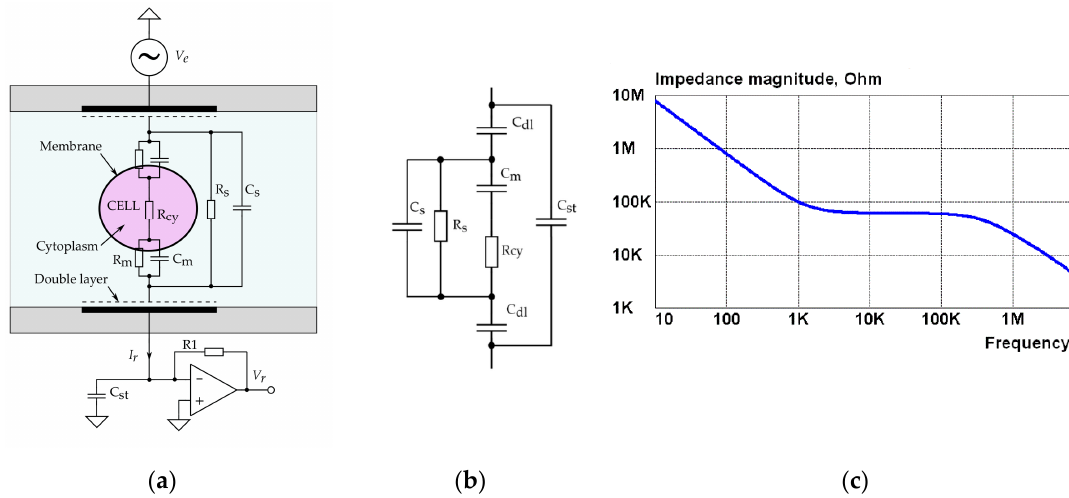
Figure 1. A magnitude spectrum ( c ) of the impedance of a single cell in saline solution ( a ) is described by a simplified electrical impedance model ( b ). The values of components are: C dl = 4 nF, C m = 1 pF, C s = 2 pF, C st = 3 pF, R s = 60 k Ω , and R cy = 100 k Ω . Magnitude spectrum ( c ) of the cell impedance is measured, applying an excitation voltage V e and measuring the response current I r through it. This is converted into a voltage V r using a transimpedance amplifier (TIA).